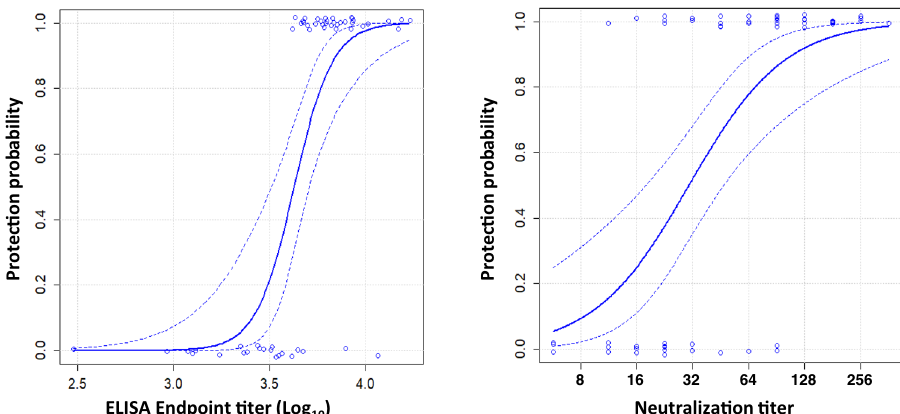
Fig. 6 Binding and neutralizing antibodies correlate with protection. Protection was de fi ned as a viral load below 10 2 TCID 50 /g in lung tissue, irrespective of vaccine regimen and dose level (see Figs. 3a, b and 4c). Syrian hamsters were immunized once, or twice, with 10 7 , 10 8 , 10 9 , and 10 10 VP Ad26.CoV2.S ( N = 56). Hamsters were inoculated with 10 2 TCID 50 SARS-CoV-2, and 4 days later sacri fi ced for virological analysis of lung tissue. Prior to virus inoculation serum samples were analyzed for a antibody-binding titers and b virus neutralizing antibodies. Median antibody responses per group is indicated with horizontal lines. Dotted lines indicate the LLOD. c Logistic regression models using Firth ’ s correction were built with protection outcome as the dependent variable, and binding and neutralizing antibody titers from pooled regimens and dose levels of Ad26.COV2.S as independent variable. Dotted lines indicate the 95% con fi dence interval. LLOD lower limit of detection, N number of animals, TCID 50 /g 50% tissue culture infective dose per gram tissue, VP virus